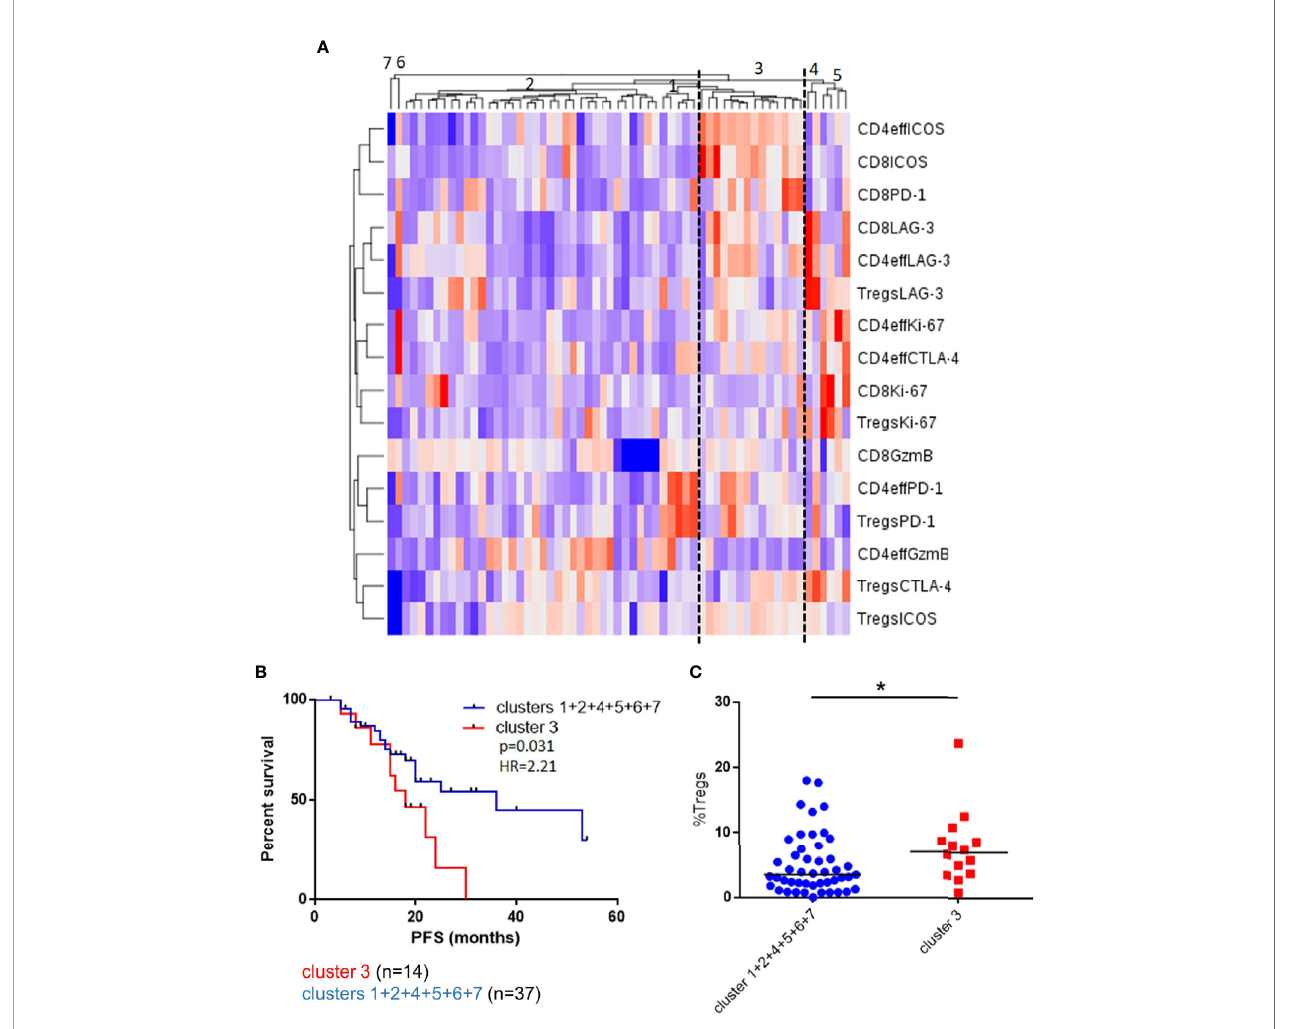
FIGURE 3 | Unsupervised clustering of BM T cell phenotype de fi nes a patient subset with a distinct phenotype and poorer outcomes. (A) Unsupervised hierarchical clustering and heatmap of activation and inhibitory receptors on CD4eff, CD8, and Treg cells in 61 patients 3 months post-ASCT. (B) PFS in patients in cluster 3 and clusters 1 + 2+4+5+6+7+8. (C) Frequency of Tregs in patients in cluster 3 and other clusters. Statistical analysis by using Mann-Whitney U test *p <